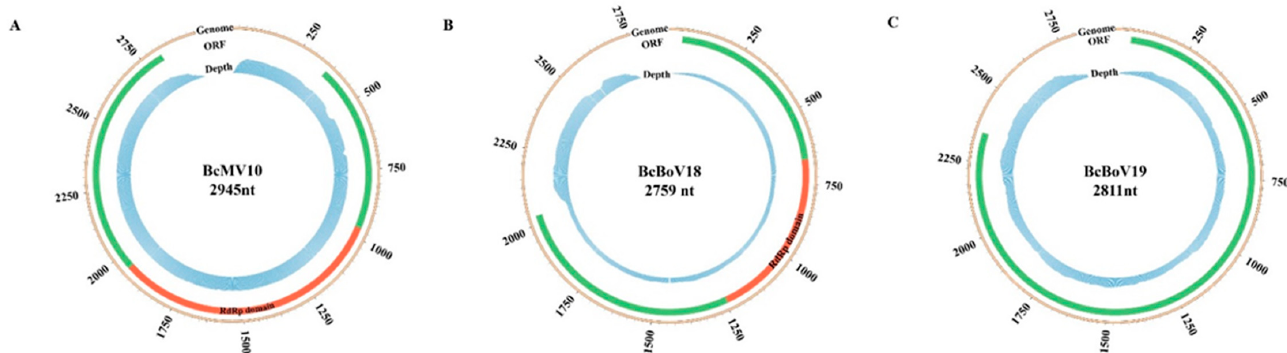
Figure 6. Profile distribution of viral reads along the full-length genomes of BcMV10, BcBoV18 and BcBoV19. Genome sequences (indicated with light brown colours), ORFs (indicated with light green colours), RdRp domains (indicated with red colours) and RNA read depth (indicated with light blue colours) of: ( A ) BcMV10; ( B ) BcBoV18; and ( C ) BcBoV19 are shown as circle graphs with different corresponding colours.